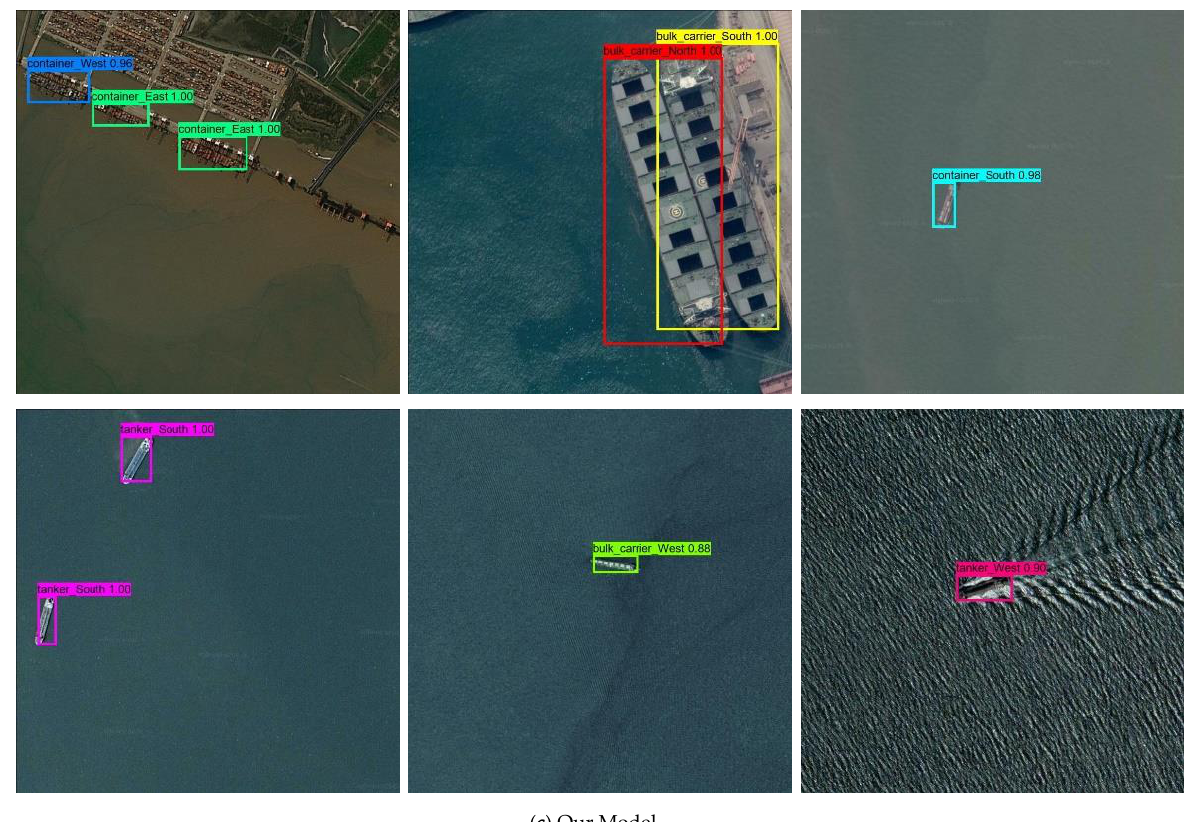
Figure 10. The experiment result for cargo ships. ( a–c ) are the detection results of cargo ships by faster-RCNN, YOLOv3, and our model, respectively.